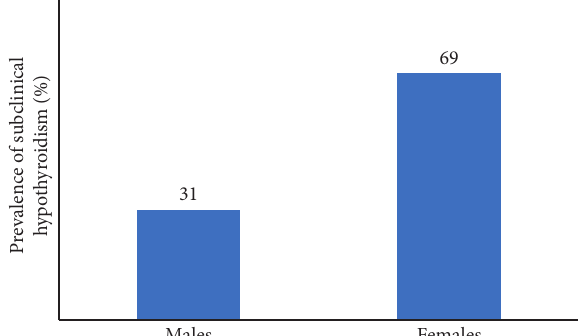
Figure 1: Prevalence of SCH in men and women.